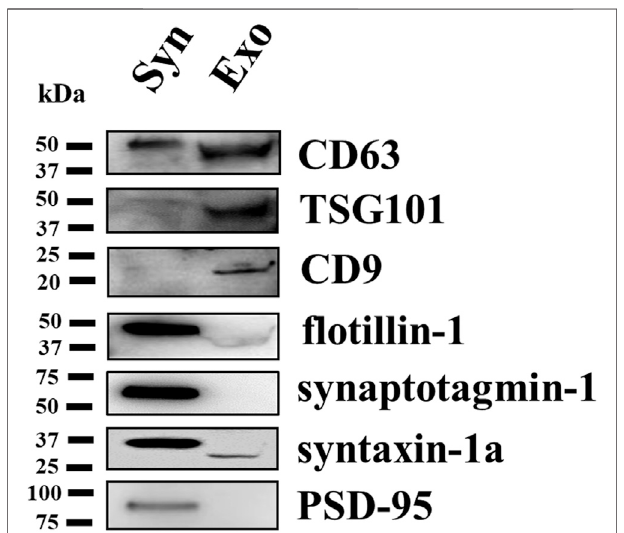
FIGURE 4 | Comparative Western blot analysis of selected proteins in the cortical synaptosomal and exosomal lysates. Identical amounts (2 μ g proteins/lane) of the cortical synaptosomal lysate (lane Syn) and of the exosomal lysate (lane Exo) were loaded on 10% SDS-PAGE and analyzed for the contents of the exosomal markers TSG101, CD63, CD9, and fl otillin-1, and of the synaptosomal markers synaptotagmin-1, syntaxin-1a, and PSD-95.Theimage isrepresentativeoftheWestern blotanalysison n (cid:1) 5 synaptosomal and exosomal preparations.